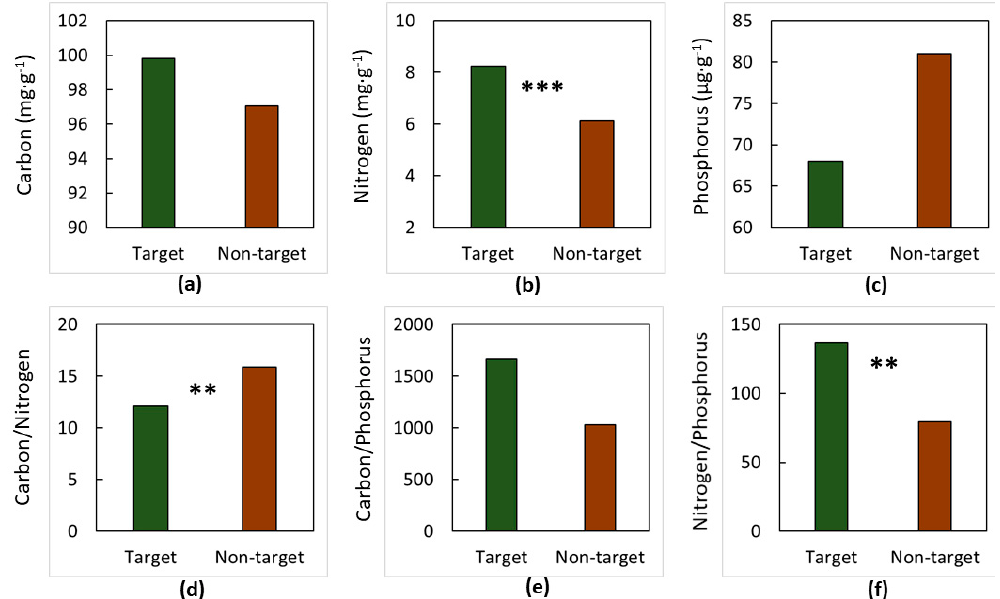
Figure 4. The influence of proximity to Cycas micronesica on soil chemical traits in Ritidian Rock Outcrop soils on Guam. Target soils were collected underneath cycad trees. Non-target soils were collected 5-m from focal cycad trees. ( a ) Total carbon; ( b ) Total nitrogen; ( c ) Olsen phosphorus; ( d ) Carbon/nitrogen; ( e ) Carbon/phosphorus; and, ( f ) Nitrogen/phosphorus. **, *** = significant at 0.01 or 0.001.